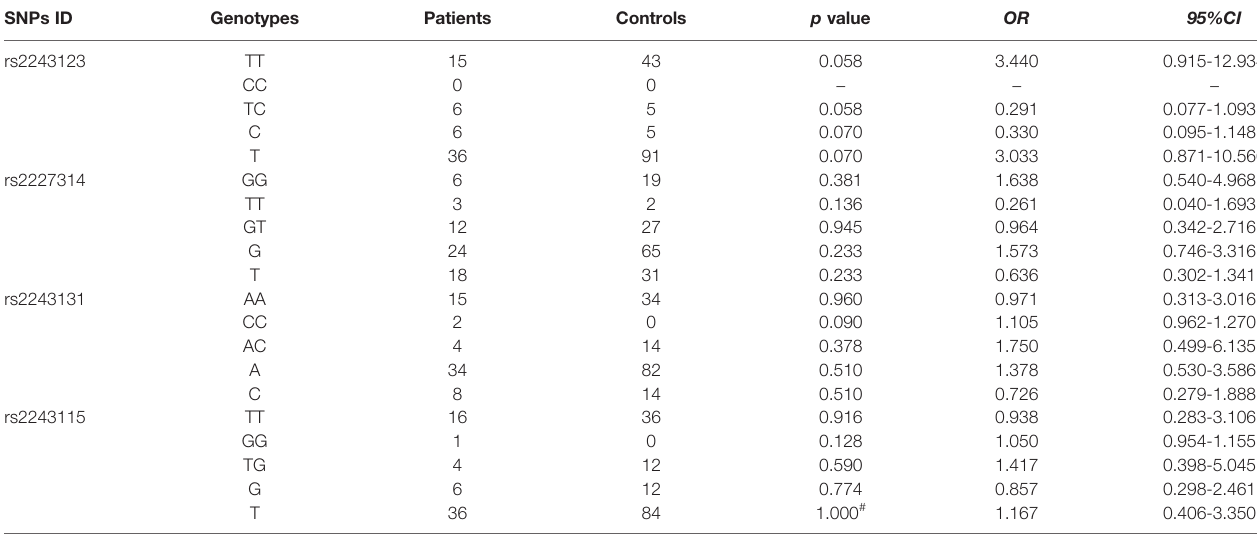
TABLE 2 | IL-12A genotypes and alleles frequencies of genotypes SNPs in VKH and healthy controls. SNPs